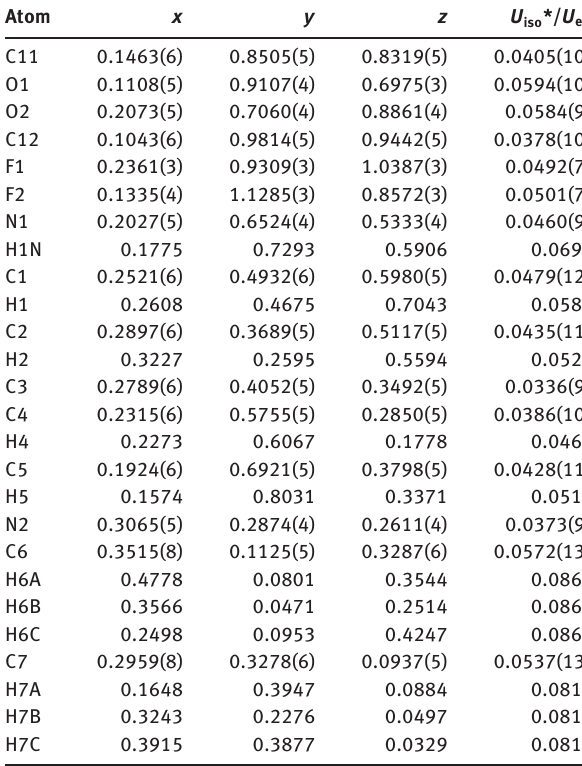
Table 2: Fractional atomic coordinates and isotropic or equivalent isotropic displacement parameters (Å 2